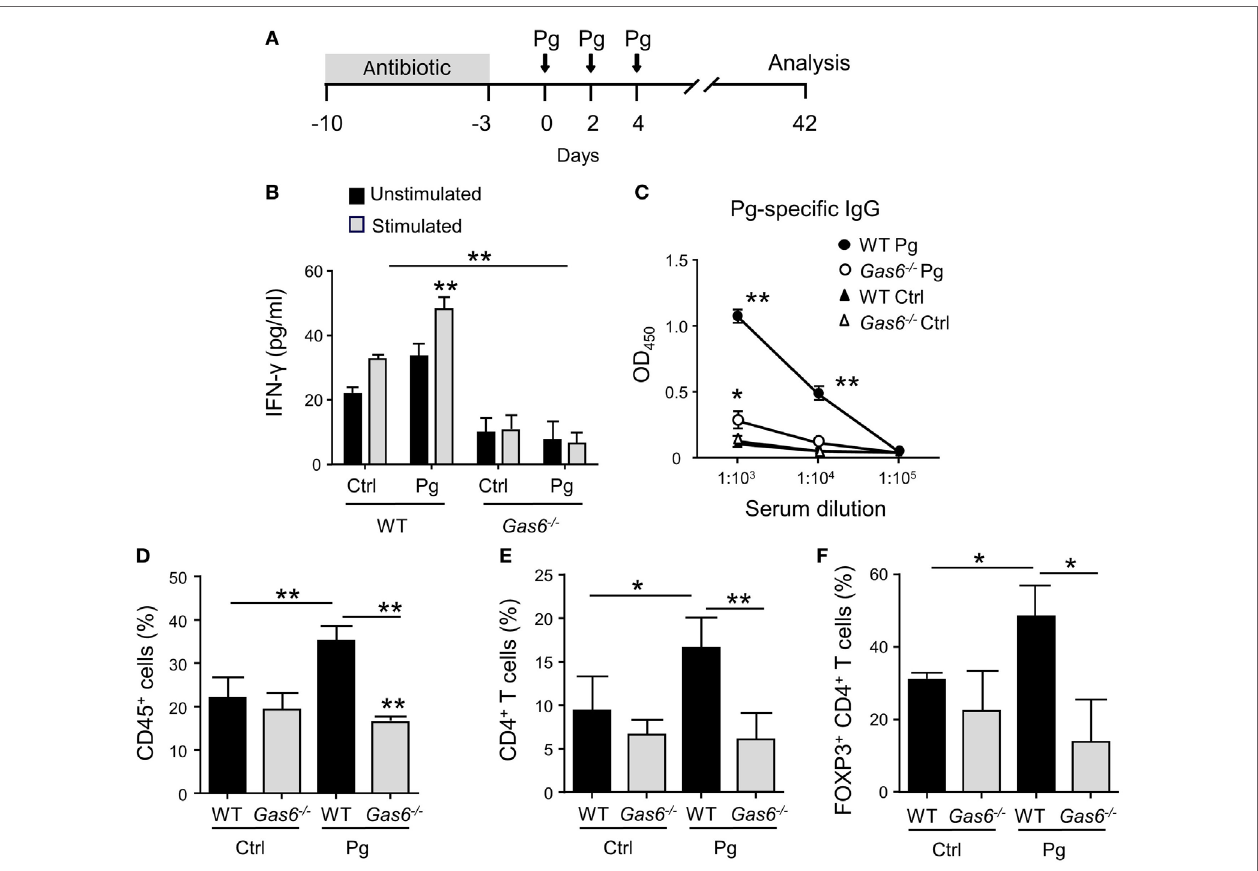
FigUre 1 | Diminished pathogen-specific adaptive immunity in Gas6 − / − mice. (a) Schematic presentation of the murine periodontitis model used in this study. Antibiotic pre-treated mice were infected via oral gavage, three times at 2-day intervals, with 1 × 10 10 CFU of Porphyromonas gingivalis strain 53977 (Pg). Six weeks after the last inoculation, the mice were analyzed. (B) IFN- γ production by restimulated splenocytes quantified by ELISA representing the mean value ± SEM ( n = 8). (c) Pg-specific IgG titers measured by ELISA in the plasma of the mice, representing the mean of OD 450 values ± SEM ( n = 8). (D–F) Flow cytometry analysis of the percentages of CD45 + cells (D) , CD4 + T cells (e) , and FOXP3-expressing CD4 + T regulatory cells (F) in the gingival tissues of infected mice ( n = 5). Representative data of one out of three independent experiments is